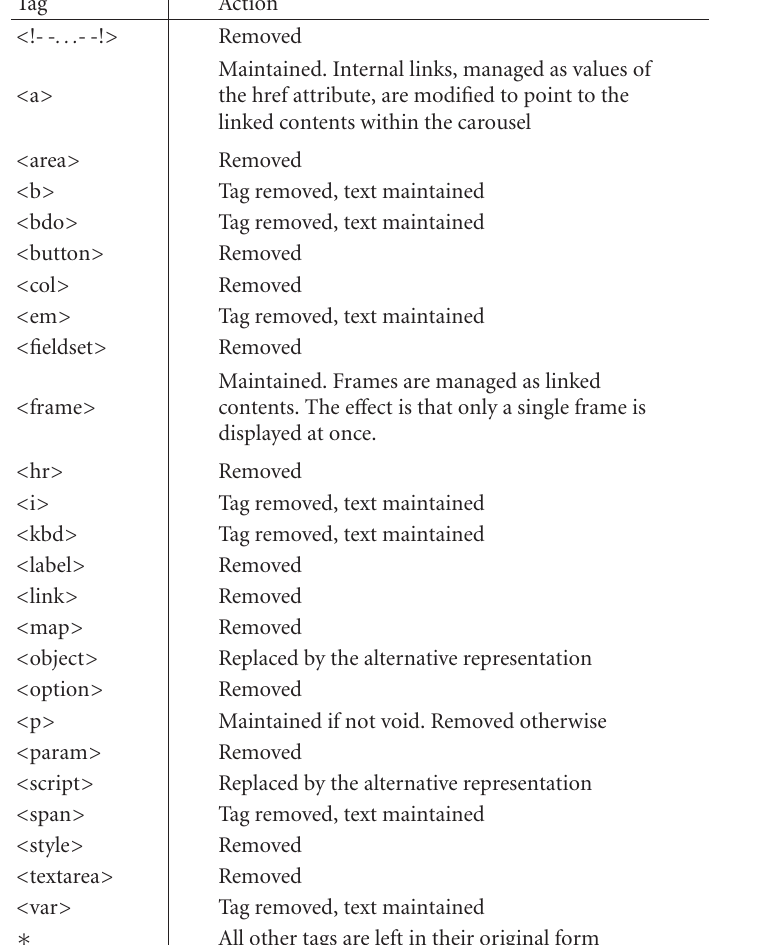
Table 1: Tag transcoding.